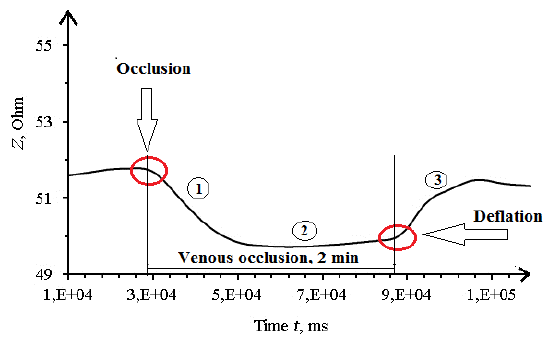
Fig. 5: The recorded electrical impedance signal.